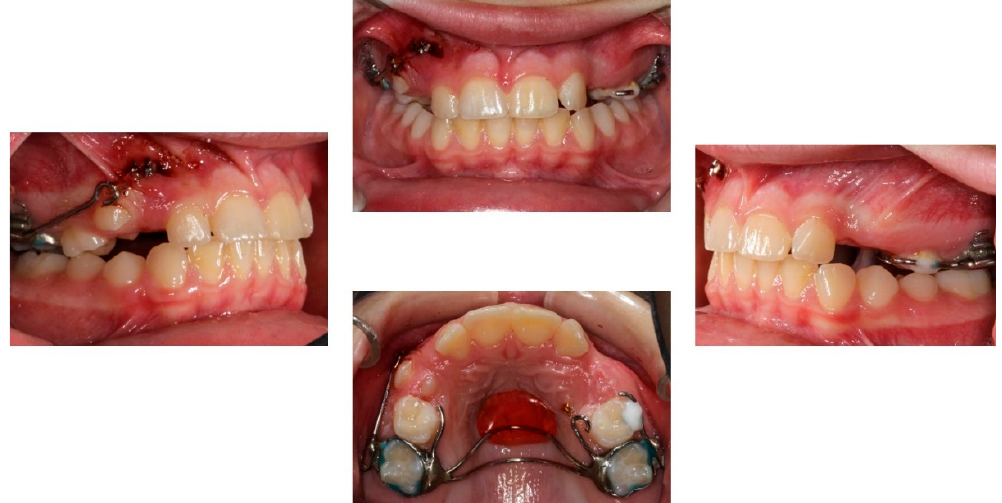
Figure 7. Progress photographs of the custom-made trans-palatal arch used for the traction of the impacted canines.